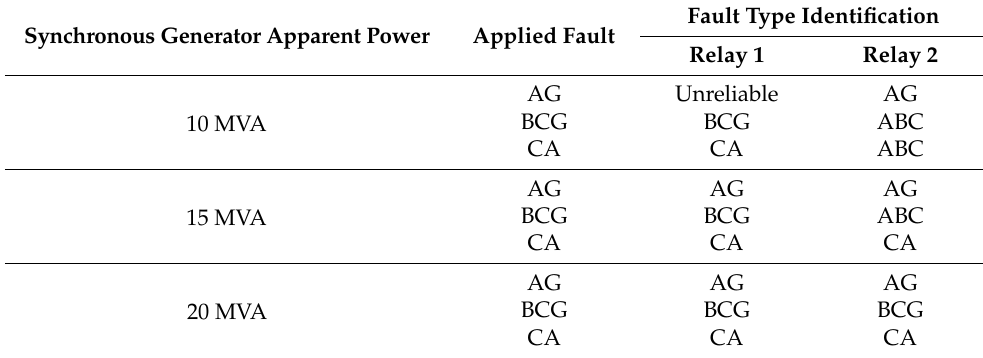
Table 4. Fault type identification of relays with added synchronous